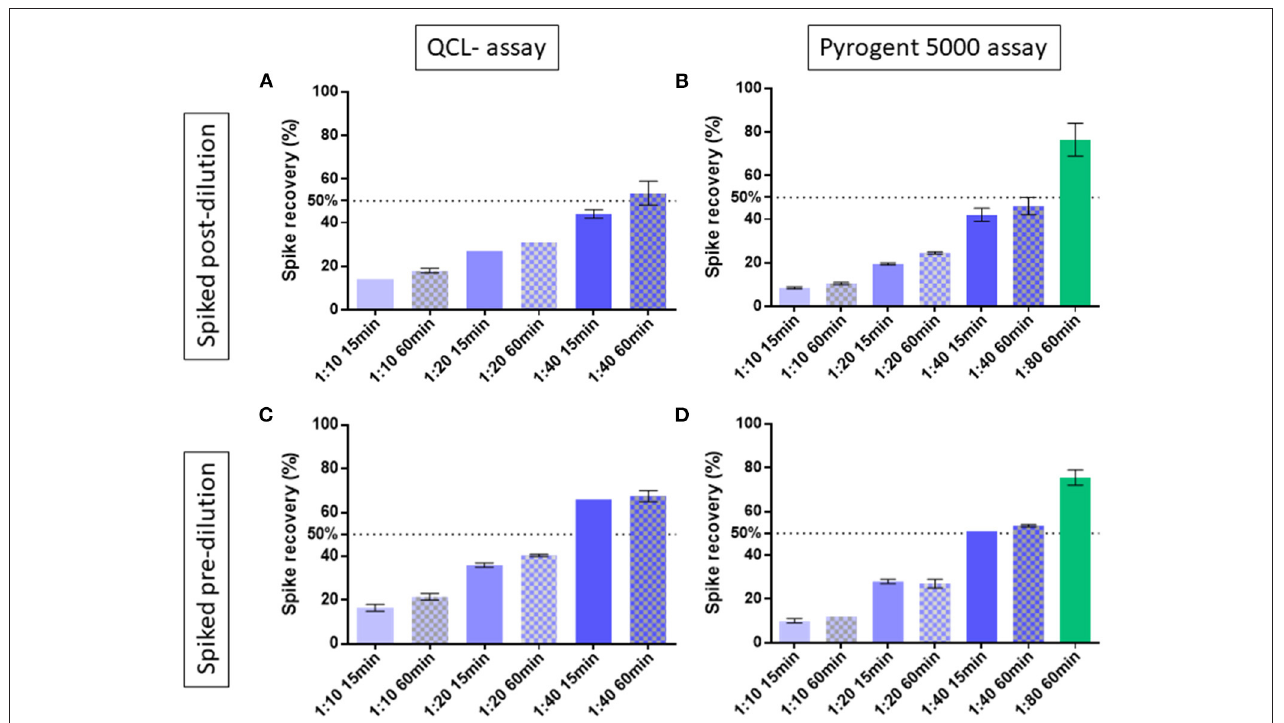
FIGURE 1 | Spike recovery in two human serum samples exposed at 15 or 60min of heat treatment and measured at different dilutions. The best condition of 1:80 dilution with 60min of heat treatment was tested with the Pyrogent-5000 assay. Median and interquartile range are shown. A line at 50% shows the limit of acceptance as defined by the United Stated Pharmacopeia ( 10). Samples were spiked with endotoxin after their final dilution and measured using (A) the QCL assay and (B) the Pyrogent-5000 assay. Samples were spiked with endotoxin before dilution and before heat treatment and measured (C) with the QCL assay and (D) with the Pyrogent-5000